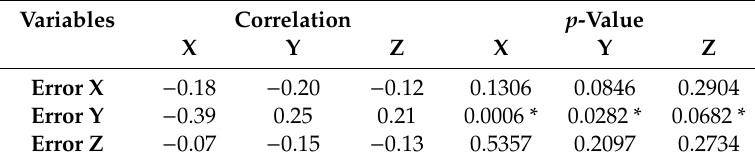
Table 9. Correlation matrix and p -value referring to error values with the 75 GCP dataset. Variables Correlation p -Value